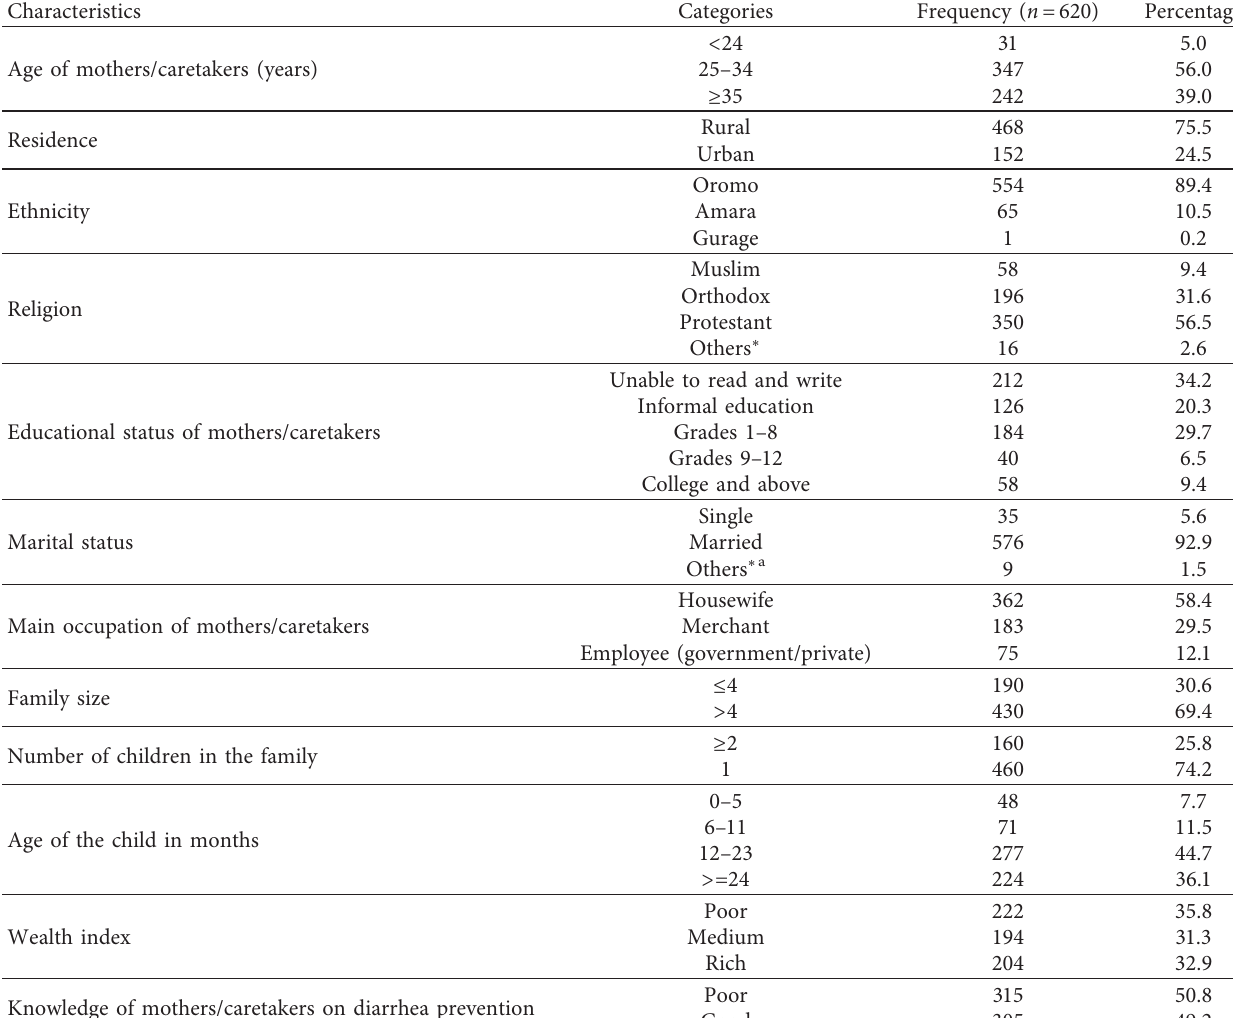
Table 1: Sociodemographic characteristics of participants in Horo Guduru Wollega Zone, Oromia Region, Western Ethiopia, from February 15 to March 10, 2018 ( n �